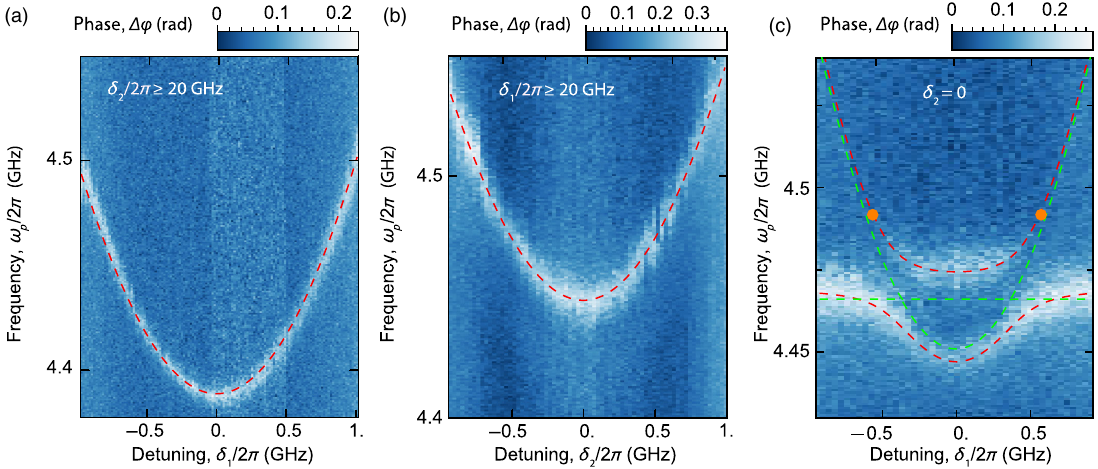
FIG. 9. Supplementary data to Fig. 3(b) showing qubit spectroscopy of the individual DQDs with the resonator tuned to ω = 2 π ¼ 4 . 726 GHz. Dashed lines are fits to extract relevant parameters. (a) Qubit spectroscopy of DQD 1 ( 2 t 1 = 2 π ¼ 4 . 392 GHz) r vs detuning δ 1 in the dispersive regime. (b) Qubit spectroscopy of DQD 2 ( 2 t 2 = 2 π ¼ 4 . 448 GHz) vs detuning δ 2 in the dispersive regime. (c) Qubit spectroscopy measuring the resonator phase shift with DQD 2 fixed ( 2 t 2 = 2 π ¼ 4 . 472 GHz, δ 2 ¼ 0 ) and DQD 1 ( 2 t 1 = 2 π ¼ 4 . 453 GHz) tuned with δ 1